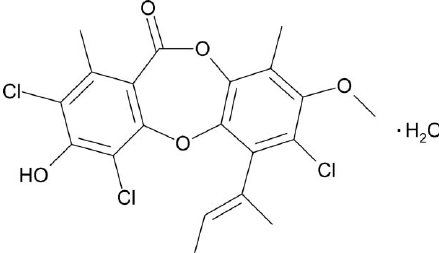
Bruker SMART APEXII CCD area-detector diffractometer Absorption correction: multi-scan ( SADABS ; Bruker, 2005)